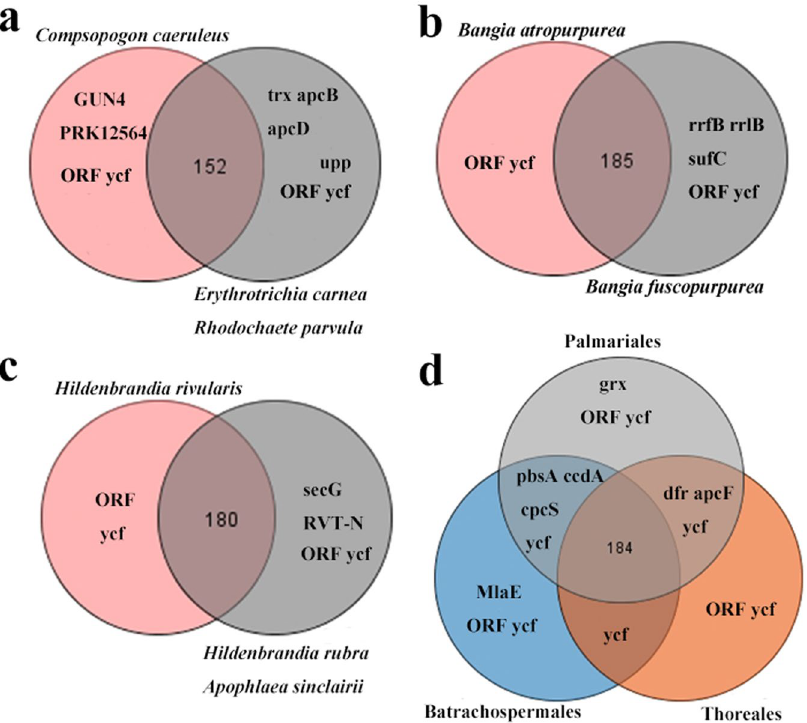
Figure 6. Venn diagram showing shared and unique gene content of each Rhodophyta class. ( a ) Venn diagram of gene content for the class Compsopogonophyceae. ( b ) Venn diagram of gene content for the class Bangiophyceae. ( c ) Venn diagram of gene content for the class Hildenbrandiophyceae. ( d ) Venn diagram of gene content for the class Florideophyceae. Note: Circles in gray represent marine members and circles in other colors represent freshwater members in each Rhodophyta lineage.